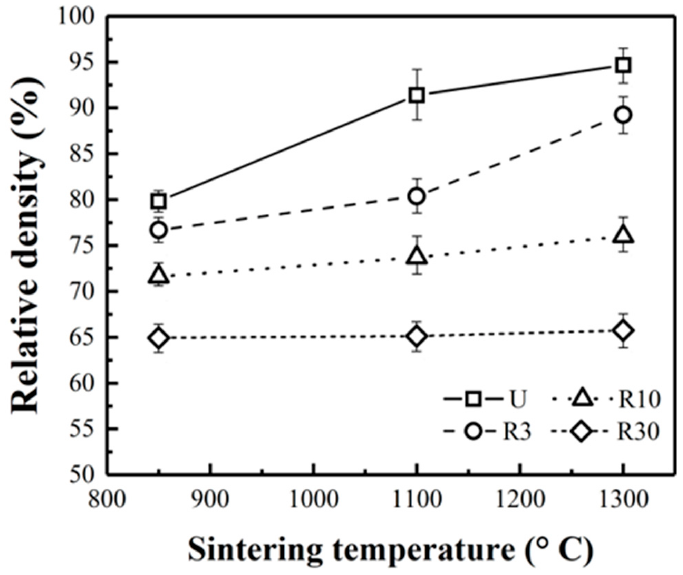
Figure 4. Densities for the set of experimental conditions, based on the Ti-TiH 2 powders and TiB 2 reinforcement particles.